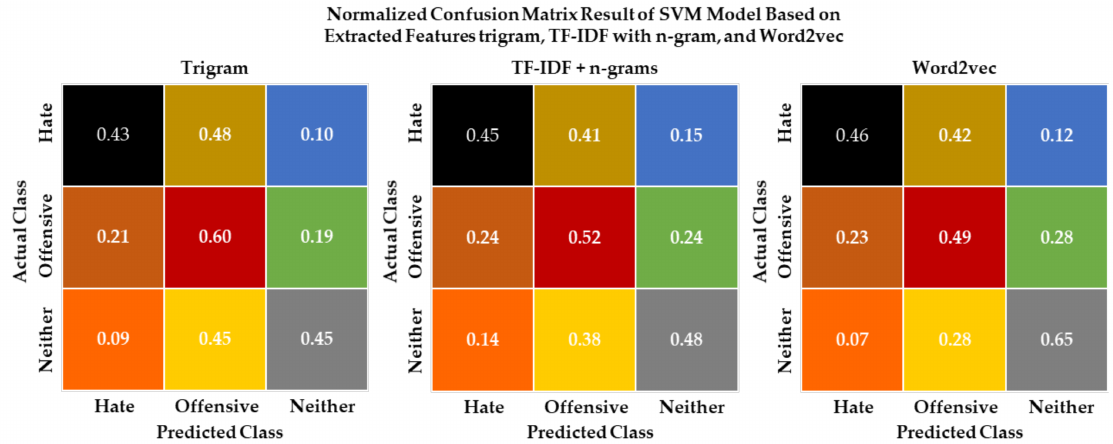
Figure 10. Confusion matrix of sample ternary SVM models based on extracted